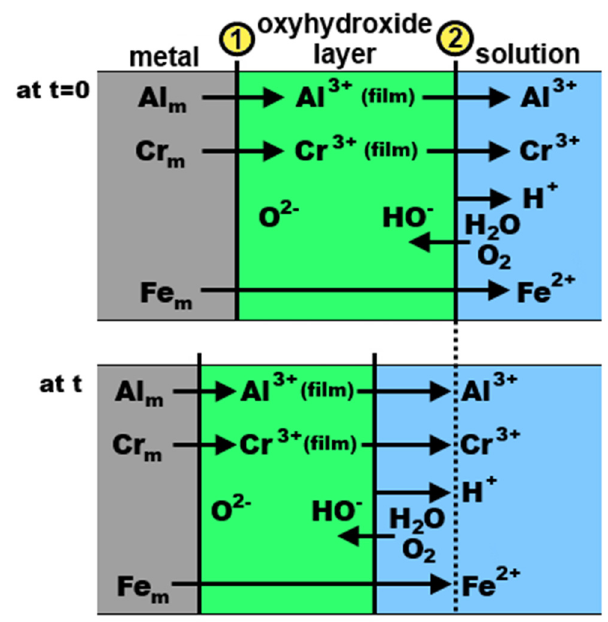
Figure 14. Schematic of the passive film evolution on γ -phase Al 64.2 Cr 27.2 Fe 8.1 alloy, re-drawn from reference [91].